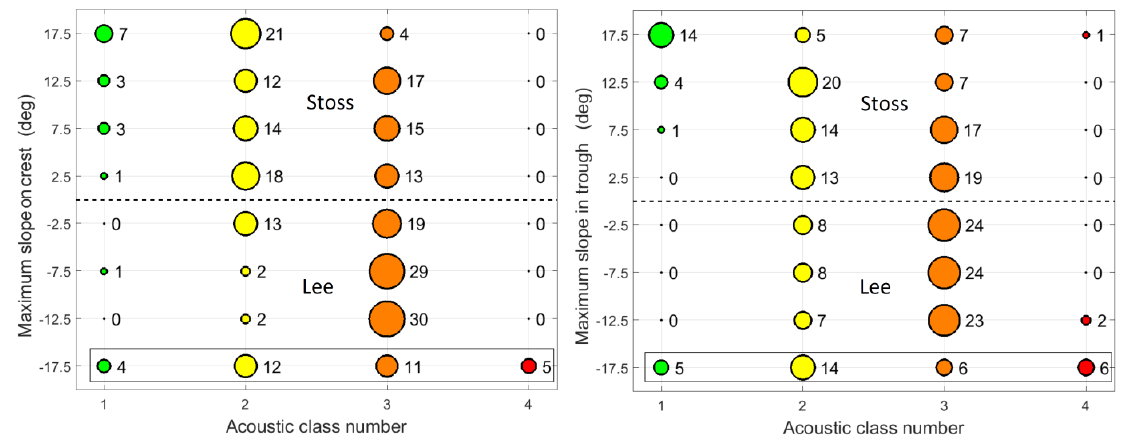
Figure 17. Histogram of maximum slopes computed in 32 typical areas with megaripple structures.